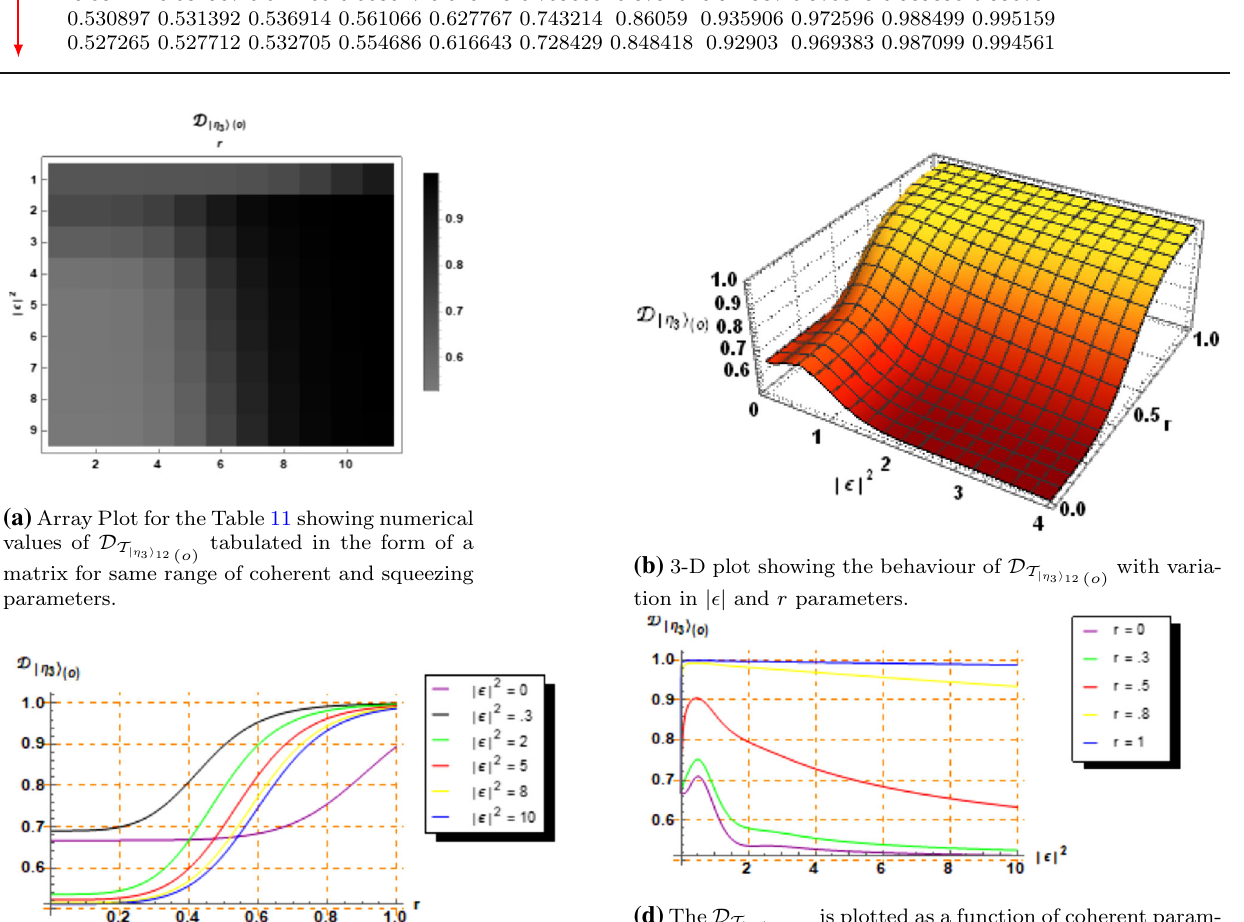
D T with varia- | η 3 (cid:2) 12 ( o )